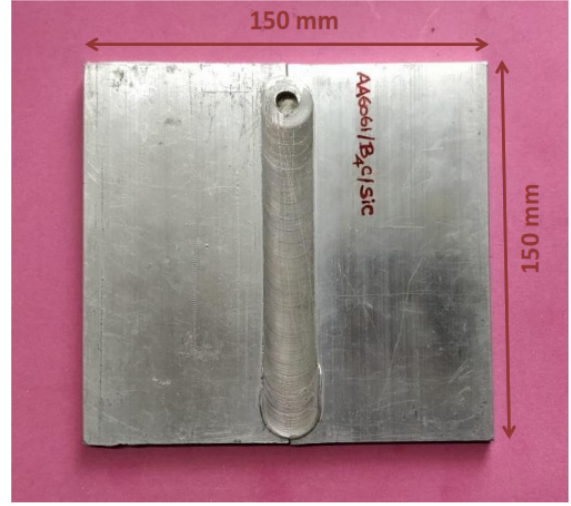
Figure 3. Friction stir welded specimen.